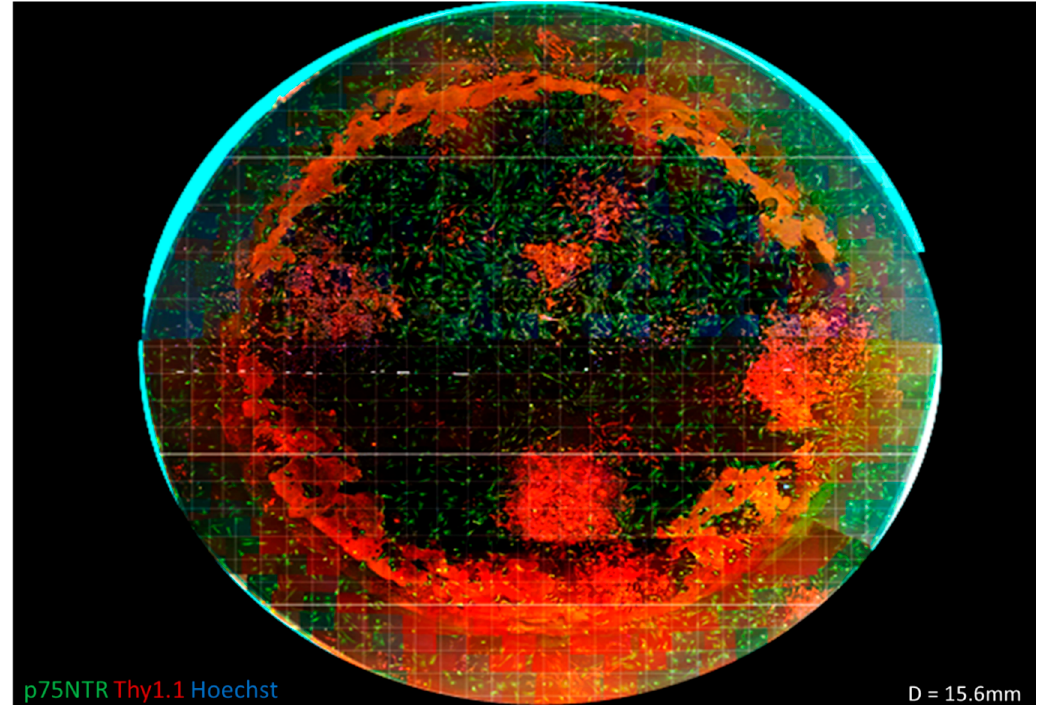
Figure 2. Assembled fluorescent micrograph of a cell population derived from rat olfactory mucosa cultured on a human feeder layer of olfactory fibroblasts. Images were taken at 100 × total magnification in a 24 well plate (diameter = 15.6 mm) and stitched together using PanoramaPro2. It can be seen from this stitched image that there are definite populations present in the well plate. There are distinct areas of Thy1.1 (red) that do not appear to be dispersed with the areas of p75NTR (green). This variety in present populations explains the large error bars found in the cell counts. When multiple views were taken for counting, the purity could range from 0–100%, which relates to a large standard deviation.